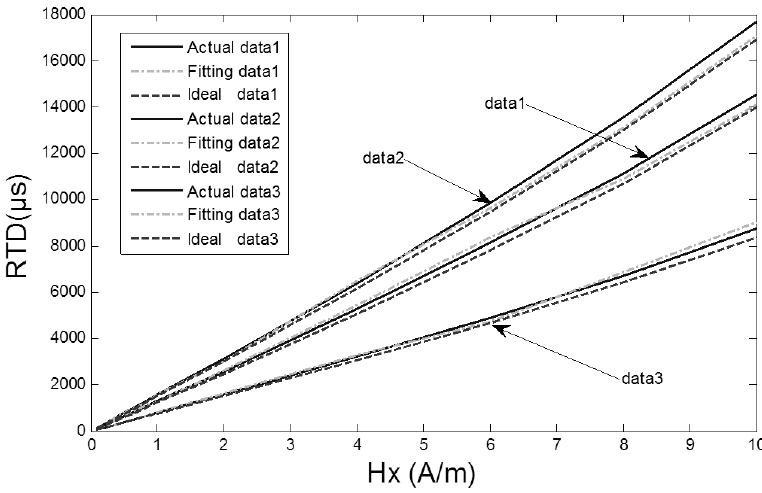
Figure 9. The output time D-values contrast of the RTD-fluxgate. Data1 is the output time D-value in the (100 mA, 5 Hz) sine excitation magnetic field. Data2 is the output time D-value in the (80 mA, 5 Hz) sine excitation magnetic field. Data3 is the output time D-value in the (100 mA, 10 Hz) sine excitation magnetic field.